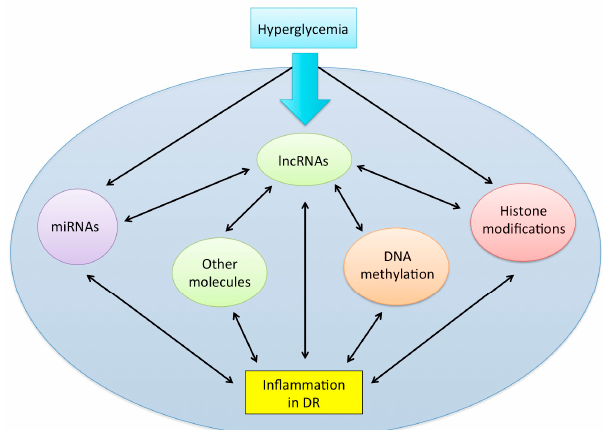
Figure 1. A schematic depicting the dynamic, coordinated network involving epigenetic modifications in inflammation during DR. Several key epigenetic mechanisms are involved in the progression of inflammation. LncRNAs may serve as critical regulators of inflammation, through their e ff ects on other epigenetic mechanisms, such as DNA methylation, histone modifications, and the activity of other non-coding RNAs (i.e., miRNAs). Furthermore, since the molecular network is heavily coordinated, several individual components of this network may inter-regulate one another, indicated by the double arrows in the figure, and future research should keep these interactions in mind.